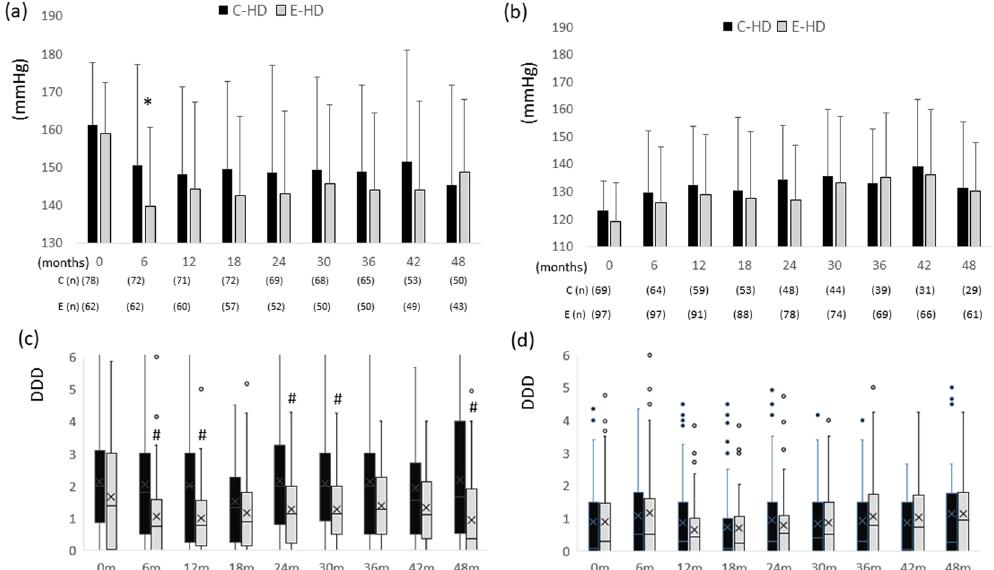
Figure 2. Changes in post-dialysis systolic blood pressure, and prescription of antihypertensive agents during the study. Patients with post-dialysis SBP ≥ 140 mmHg (n = 139) at baseline (0 month): changes in